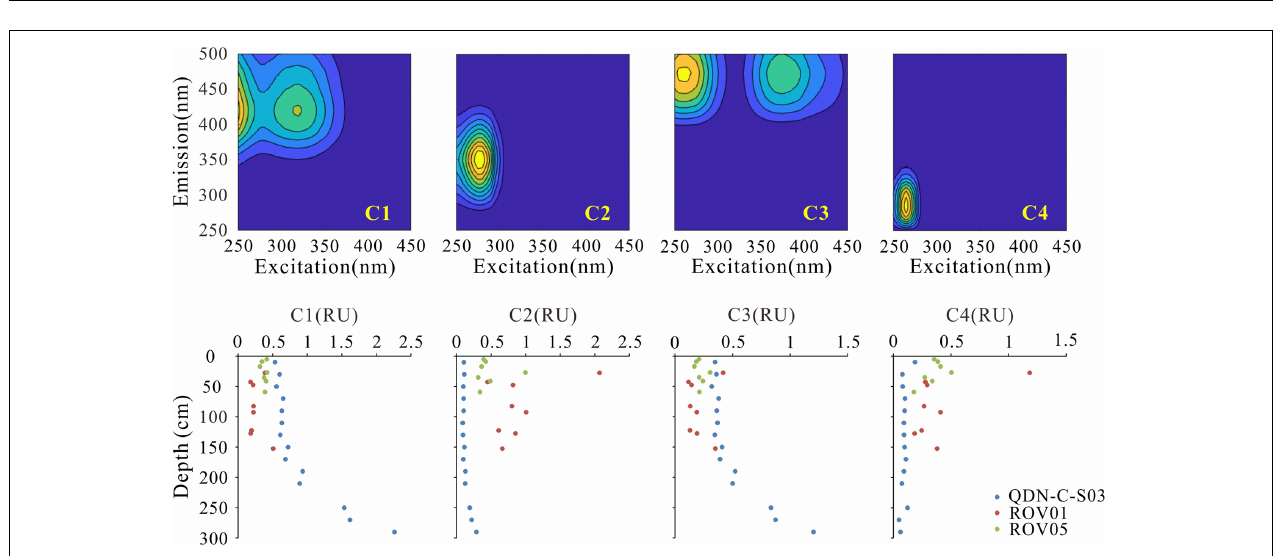
FIGURE 3 | Contour plots of the four components identified by EEM-PARAFAC (upper panel) and depth-profiles of the corresponding fluorescent intensities of fluorescence dissolved organic matter (FDOM) components (lower panel).